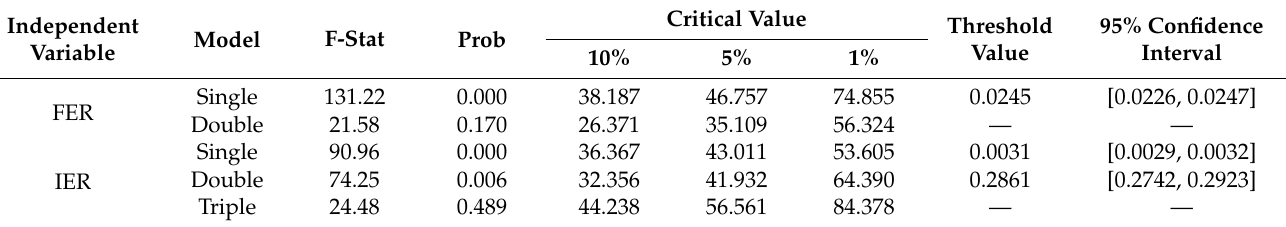
Table 10. The test of a threshold effect.